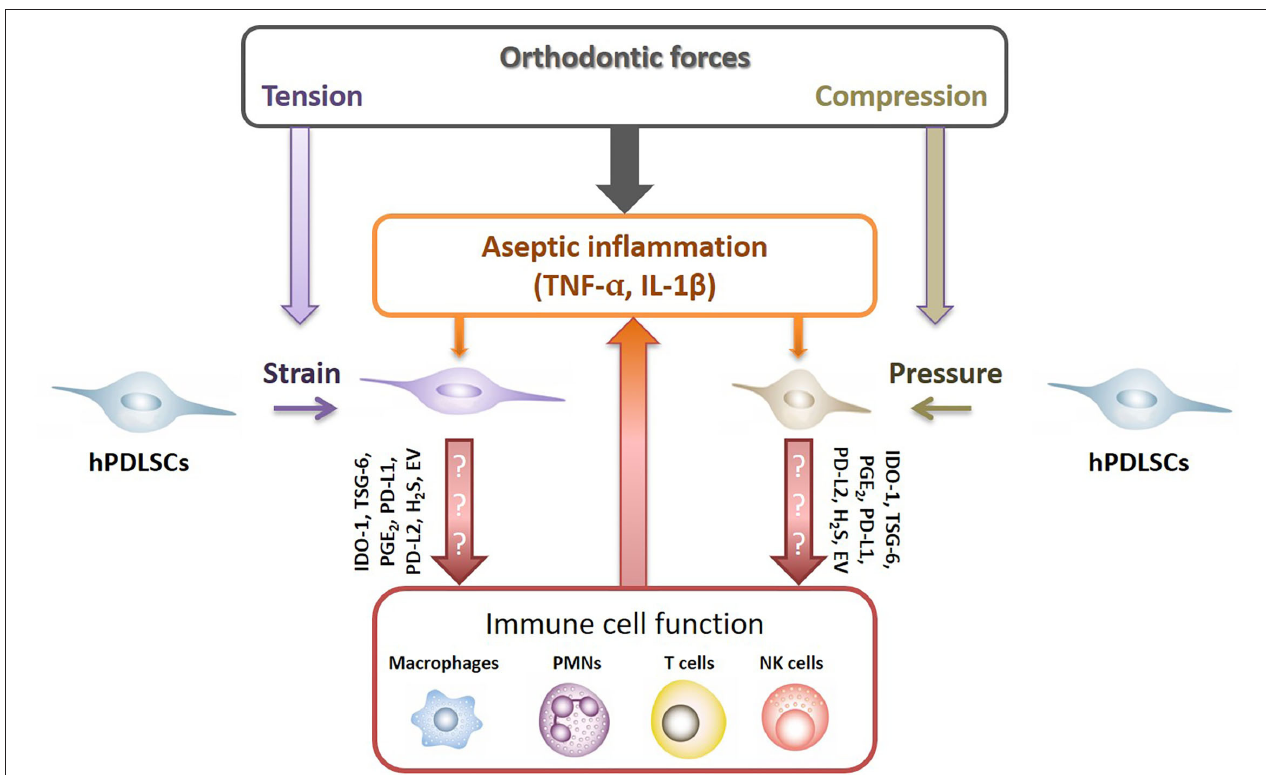
FIGURE 1 | Potential crosstalk between hPDLSCs and immune cells after applying orthodontic forces. Under inflammatory conditions hPDLSCs significantly modulate local immune responses by affecting various immune cells, such as macrophages, neutrophiles (PMNs), NK cells and T lymphocytes. hPDLSCs execute their immunomodulatory activities via various mechanisms which are boosted by various pro-inflammatory cytokines, such as TNF- α , IL-1 β , and IFN- γ [ 25–29]. Hence, it seems likely that the non-infectious inflammatory conditions during OTM modulate the immunomodulatory activities of hPDLSCs, which in turn should influence the activity of immune cells. Indoleamine-2,3-dioxygenase-1 (IDO-1), tumor necrosis factor-inducible gene 6 protein (TSG-6), prostaglandin E 2 (PGE 2 ), programmed cell death ligand 1/2 (PD-L1/2), hydrogen sulfide (H 2 S), extracellular vesicles